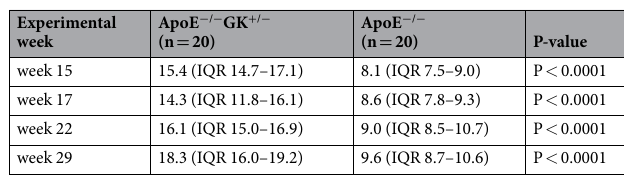
Table 1. Blood glucose levels in ApoE − / − GK + / − and ApoE − / − mice. Mann-Whitney t-test for nonparametric data was used for comparisons between the two groups. Data is presented as median with interquartile